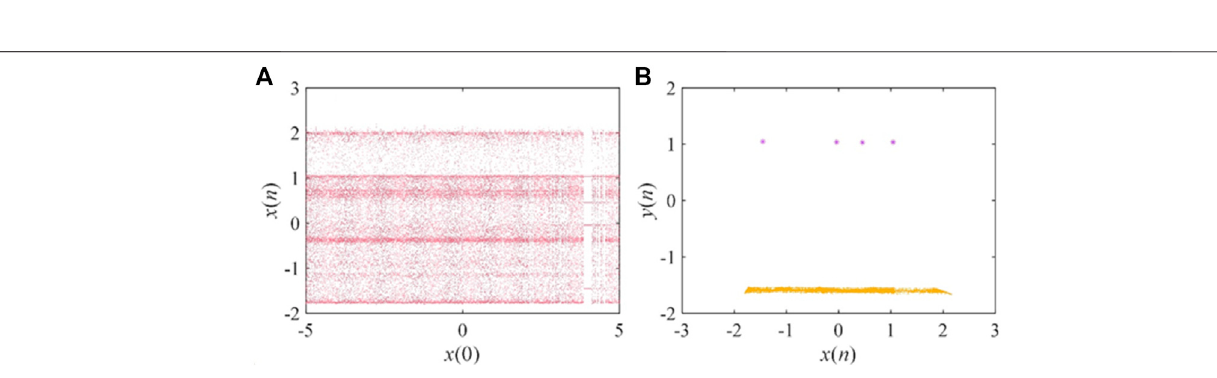
FIGURE 7 | Experimental results graph when a = 1.03. (A) Bifurcation with initial value x (0); (B) Attractors coexistence phase diagram.